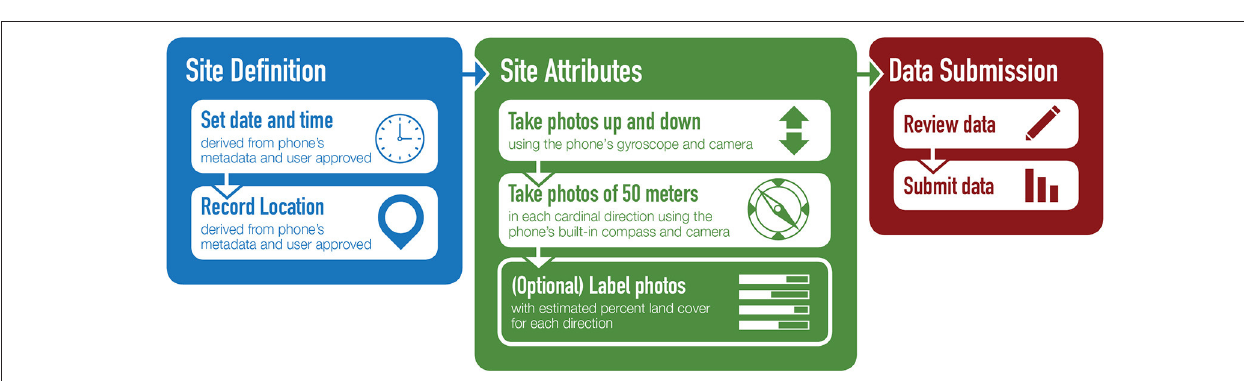
FIGURE 2 | Task flow for a GLOBE Observer Land Cover observation. Users review all data submitted, including